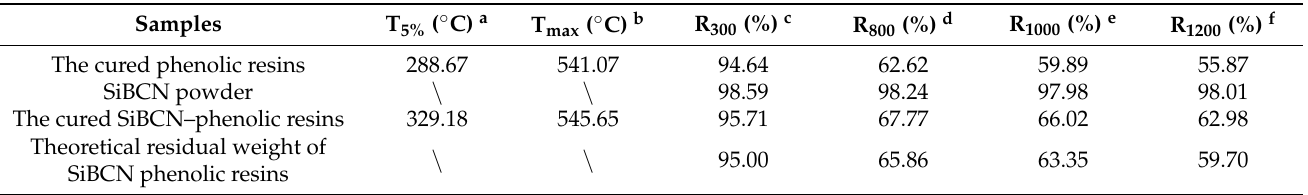
Figure 2. Thermogravimetric (TG) curves of the cured phenolic resins and the cured SiBCN phenolic resins in N 2 atmosphere. Table 1. Thermogravimetric analysis (TGA) results under N 2 atmosphere of the cured phenolic resins and the cured SiBCN phenolic